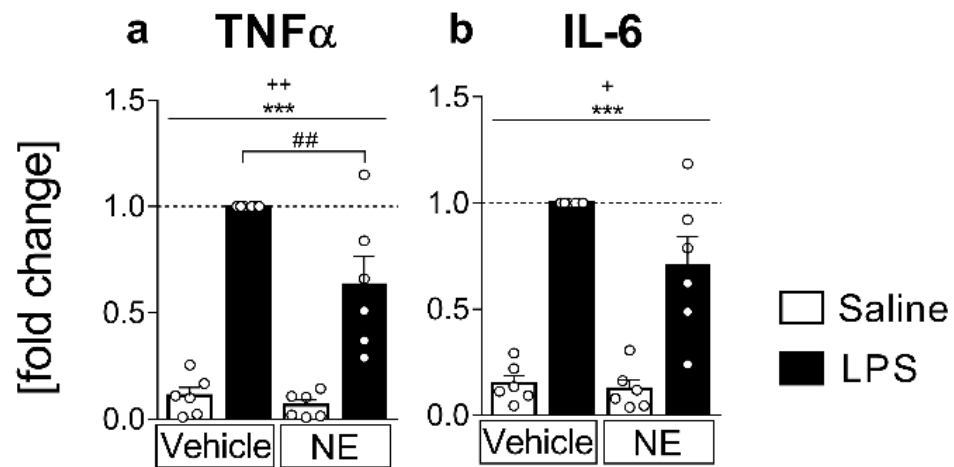
Figure 1. Bioassay cytokine measurements from supernatants: Release of the proinflammatory cy- tokines tumor necrosis factor α (TNF α , ( a ) and interleukin (IL)-6 ( b ) into the supernatants of primary sensory circumventricular organ (sCVO) cultures. Cells were stimulated with lipopolysaccharide (LPS, 10 µ g/mL) or saline and simultaneously treated with norepinephrine (NE, 1 µ mol/L) or vehicle for 4 h. For every sample set, cytokine concentrations are plotted as fold change to the LPS-treated sample (LPS+vehicle) from six independent experiments. TNF α and IL-6 secretion increased after LPS stimulation (* main effect LPS stimulation), whereas NE treatment lowered basal and LPS-induced secretion of both cytokines into the supernatants (+ main effect NE treatment). LPS-induced TNF α release was significantly dampened by NE (# LPS+vehicle vs. LPS+NE). n = 6 per group; two-factorial ANOVA, Bonferroni post hoc test, *** p < 0.001; + p < 0.05, ++ p < 0.01; ## < 0.01. 2.2. mRNA-Expression Analyses of Inflammatory Marker Proteins: LPS-Induced Inflammation Increased IL-6 and TNF α -Activated Signaling Pathways, the Anti-Inflammatory Cytokine IL-10, and the Lipid-Metabolizing Enzymes COX-2, but Decreased Ephx2 mRNA expression levels of pro- and anti-inflammatory markers and enzymes regu- lating lipid mediator synthesis were used to further assess lipid metabolism and cytokine signaling pathways. Inhibitors of (I) κ B α and SOCS3, respectively, were used as common indicators and negative feedback inhibitors of TNF α and IL-6 signaling via the proinflam- matory transcription factors NF κ B and STAT3 [44,45]. I κ B- and SOCS3-mRNA expression showed a robust significant increase in LPS-stimulated groups (Figure 2a,b) confirming a proinflammatory activation of cells via the NF κ B- and STAT3 pathway (I κ B p < 0.0001, SOCS3 p = 0.0383). NE treatment only tended to lower I κ B mRNA expression, suggesting that the contribution of TNF α to this response was limited (Figure